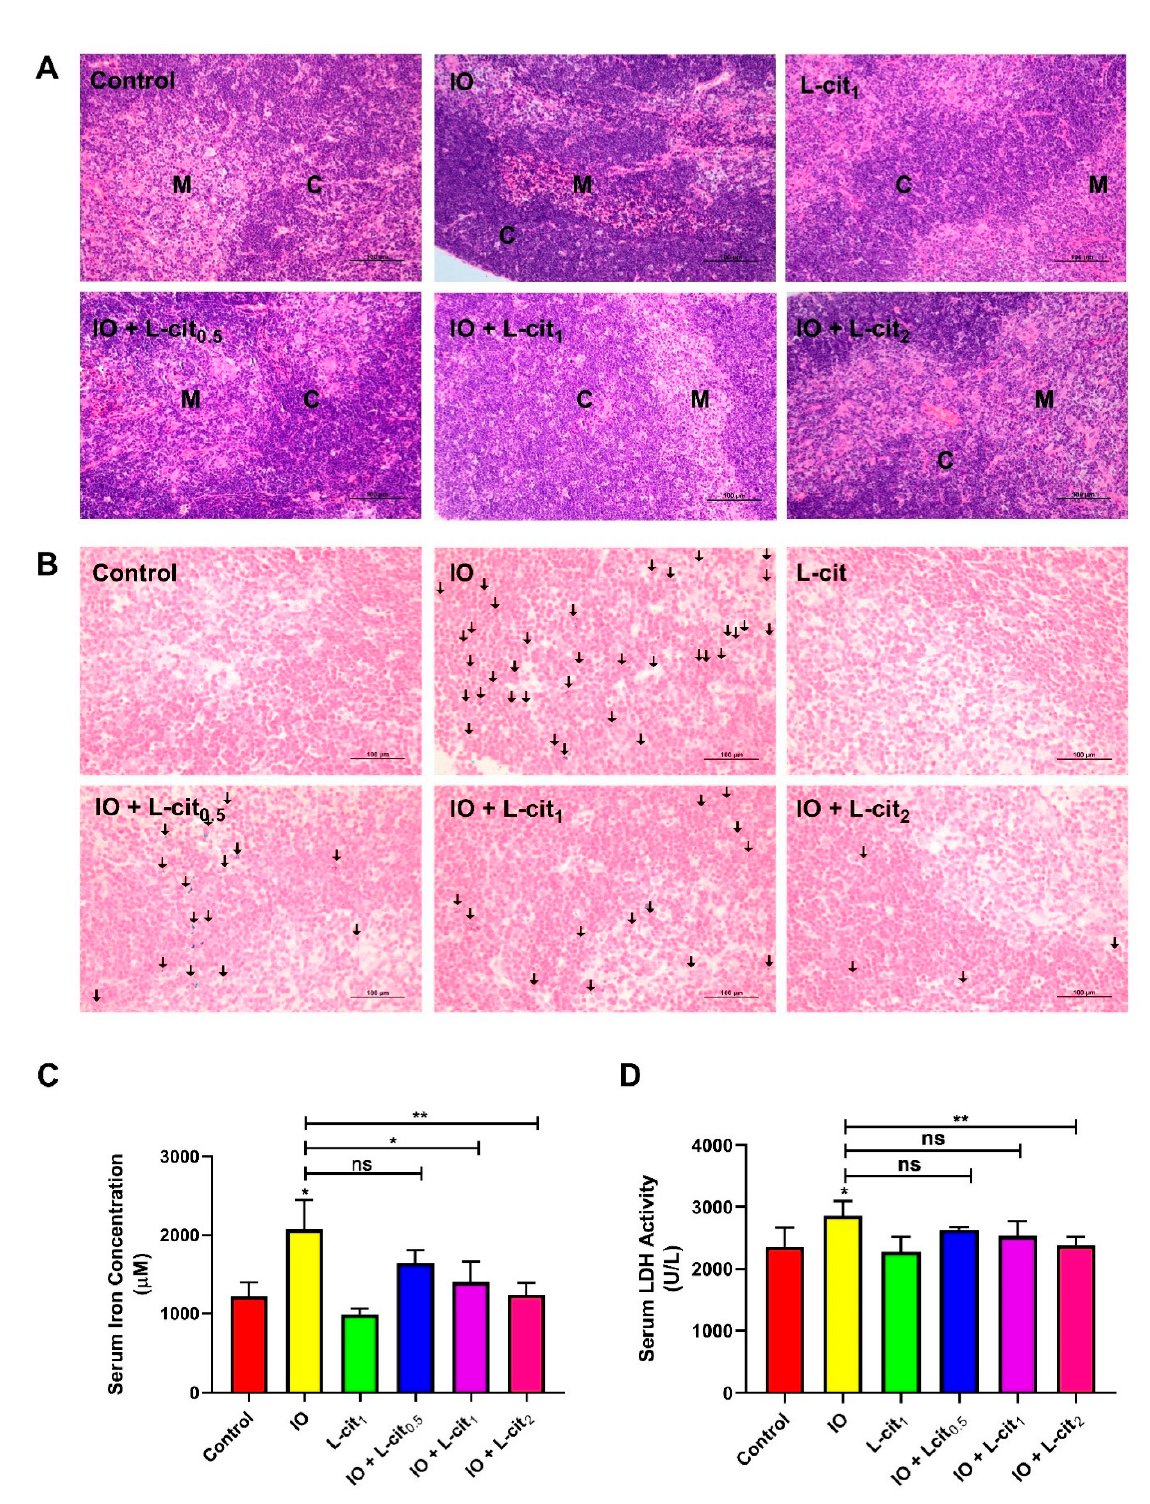
Figure 1. L-cit alleviates mouse thymus damage and inhibits the iron deposition and LDH activity. Mice were intraperitoneally injected with iron dextran 50 mg/kg, and L-cit was given by gavage administration with a dosage of 0.5, 1.0, and 2.0 g/kg/day. ( A ) HE staining of thymus (C represents the thymic cortex, M represents thymus medulla). ( B ) Prussian blue staining of thymus (the arrow indicates iron deposition). ( C ) Iron concentration in serum. ( D ) LDH activity in serum. Values represent mean ± SEM. of three independent experiments. Significant differences are represented by * p < 0.05, ** p < 0.01, ns (not significant).